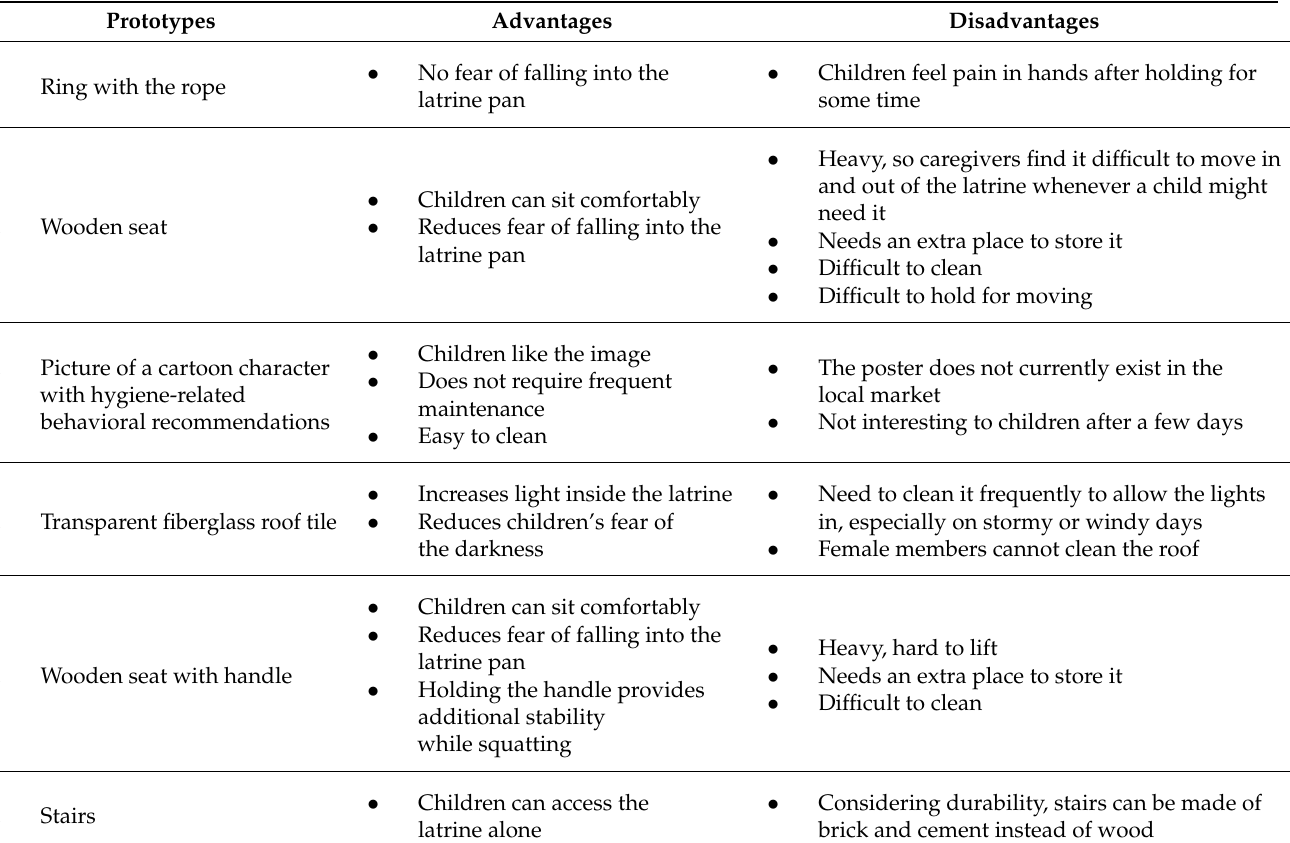
Table 4. Responses of users to six enabling technologies for child-friendly